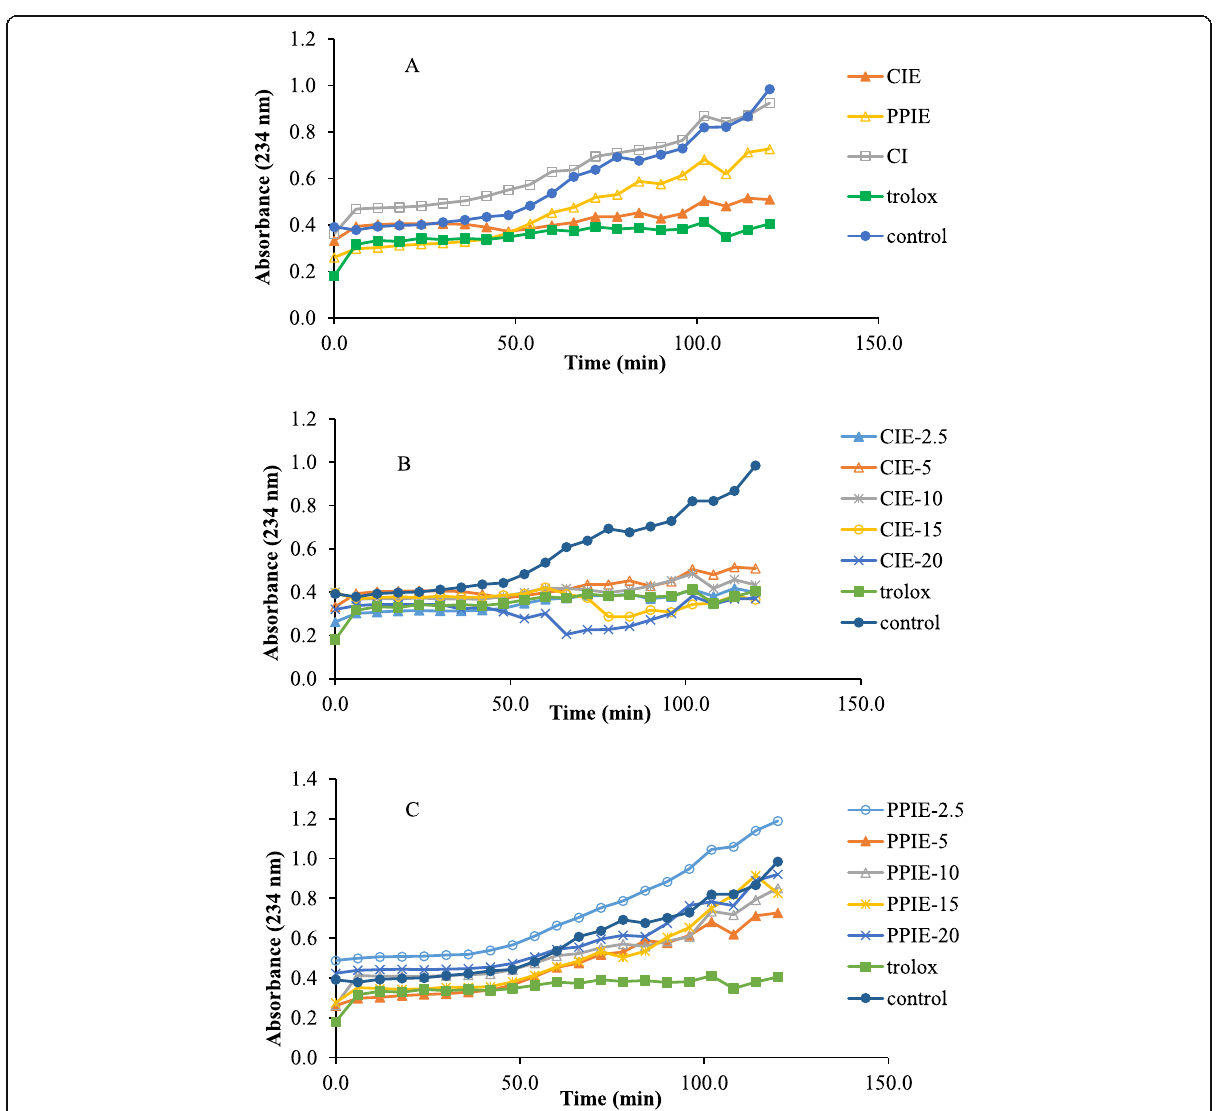
Fig. 6 Conjugated dienes formation from lipid oxidation in aqueous system influenced by adding inulin. a CIE (crude inulin extract from JA), PPIE (primary purified inulin extract from JA) and CI (commercial inulin from chicory root) solutions with the same concentration; b Different concentrations of CIE; c Different concentrations of PPIE. Each data point represents mean ( n = 3). One-way ANCOVA followed by post-hoc Tukey ’ s test is used to find significant differences ( α = 0.05). Results are different when P <